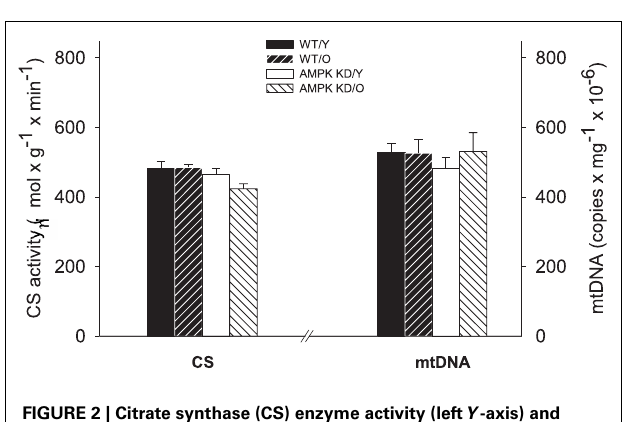
FIGURE 2 | Citrate synthase (CS) enzyme activity (left Y -axis) and mitochondrial DNA content (right Y -axis) in heart muscle samples from wild type mice (WT) and dominant negativeAMPK α 2 (AMPK KD) mice. Young (Y: 19–22weeks) and old (O: 76–91weeks) mice were studied in both groups. *Different from age matched wild type ( P < 0.05).